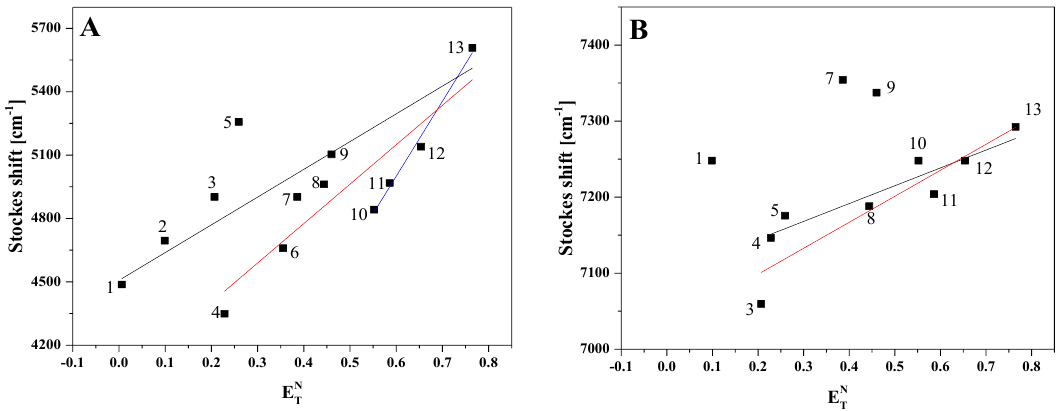
Figure 4. Panel ( A ): Stokes shift variation with normalized value of solvent polarity for FABT. Panel ( B ): Stokes shift variation with normalized value of solvent polarity for ADAPT dissolved in different solvents (1—cyclohexane, 2—toluene, 3—THF, 4—ethyl acetate, 5—chloroform, 6—acetone, 7—DMF,